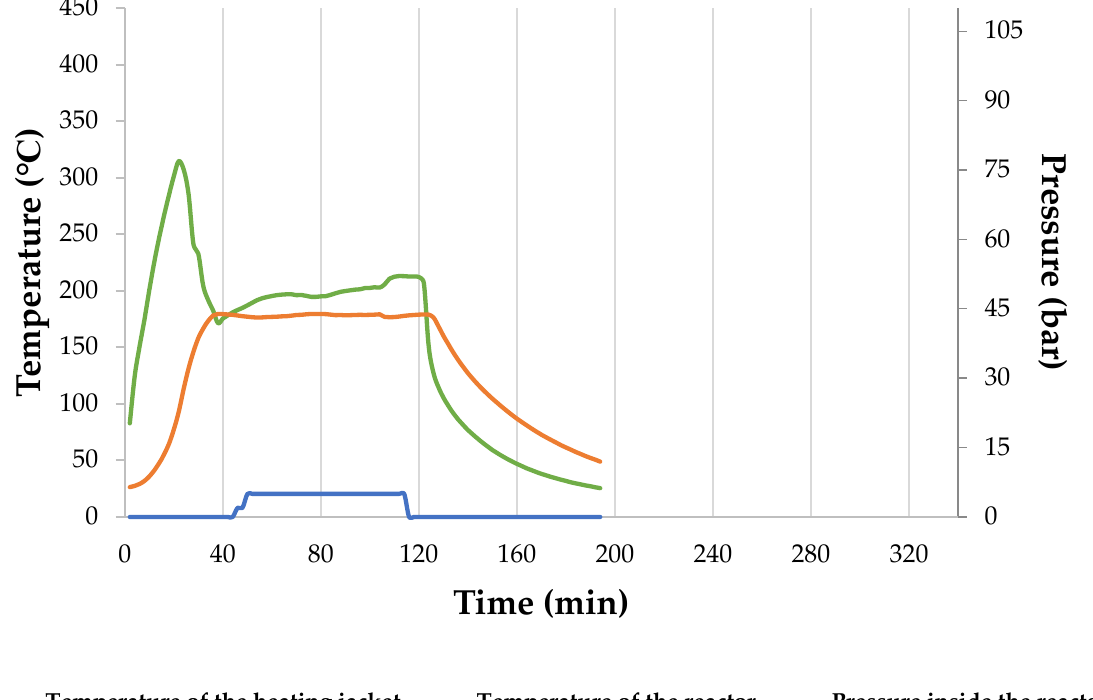
Figure A2. Temperature and pressure patterns during the process at 180 ◦ C in 90 min.